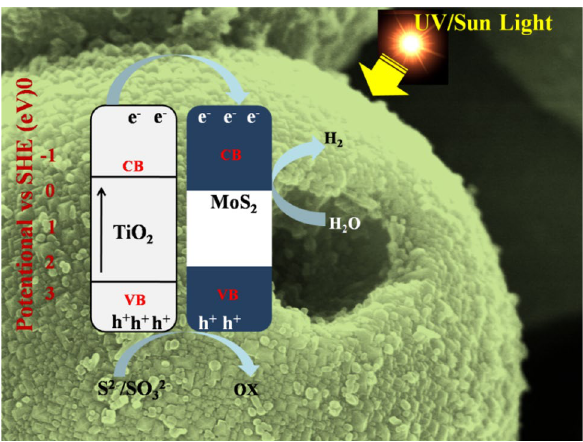
Fig. 11 Charge transfer between TiO